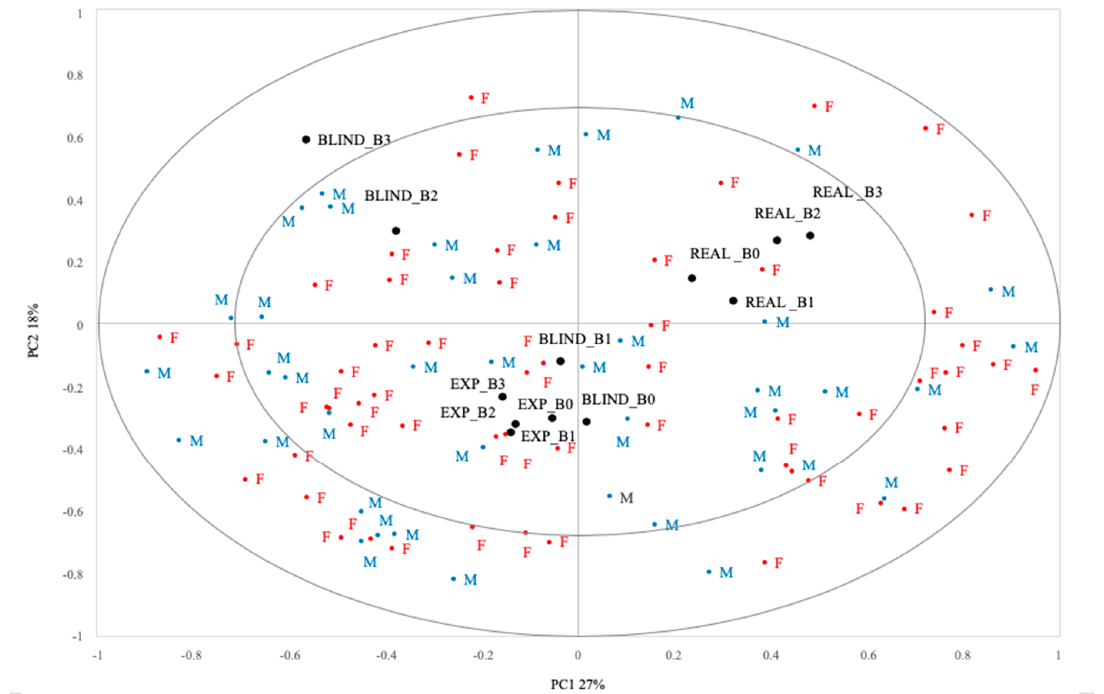
Figure 4. Correlation loadings with consumers and the four samples evaluated in the three conditions.